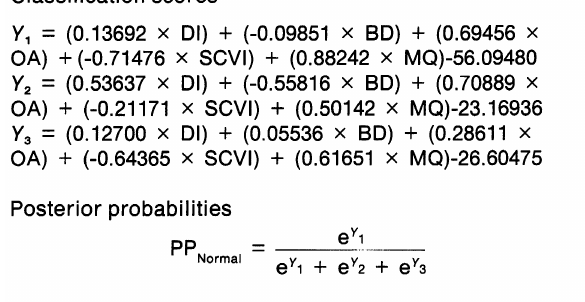
TABLE II. Classification formula by which patients can be classified as normal or demented, and if demented, as more Alzheimer- or Huntington-like. 01 is digit span, BO is block design, OA is object assembly (WAIS-R subtests, age-scaled scores), SCVI is age-scaled visual repro duction score (WMS) andMQ is Memory Quotient (WMS). Cases are classified according to the highest posterior probability